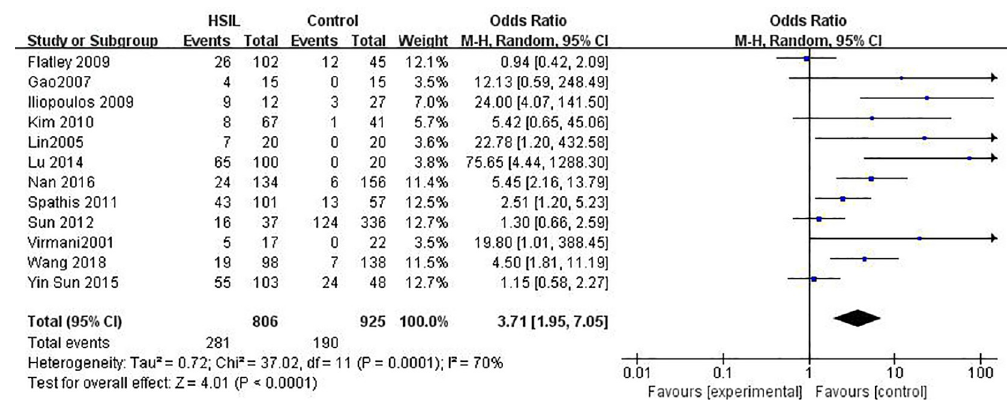
Fig 3. Funnel plots for associations of MGMT promoter hypermethylation with the risk of HSIL. The squares represent the ORs for individual studies. The size of the square reflects the weight of included studies. Bars represent the 95% confidence intervals (CIs). The center of the diamond represents the summary effect size. HSIL, high-grade intra-epithelial lesion.